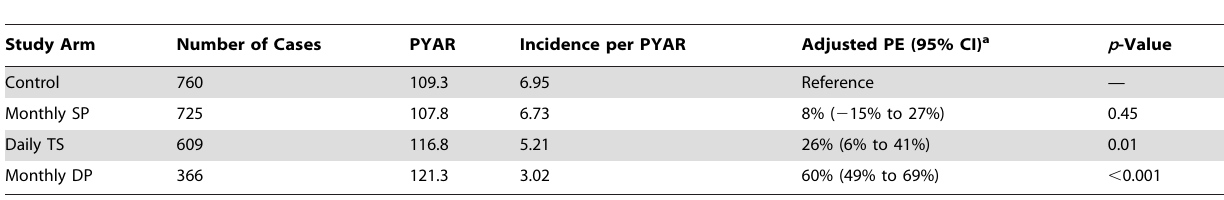
Table 3. Protective efficacy against incident episodes of malaria using multivariable analyses.